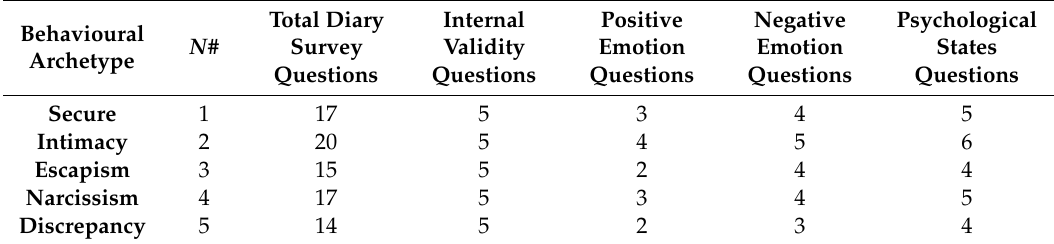
Table 12. Descriptive of the diary survey questions.